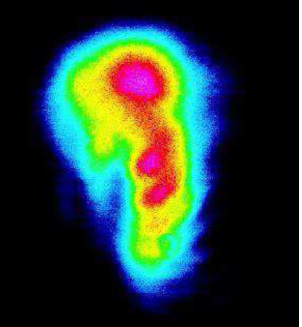
FIG. 8. Input laser profile measured at the end of the laser diagnostic line with telescope actuator at 12.5